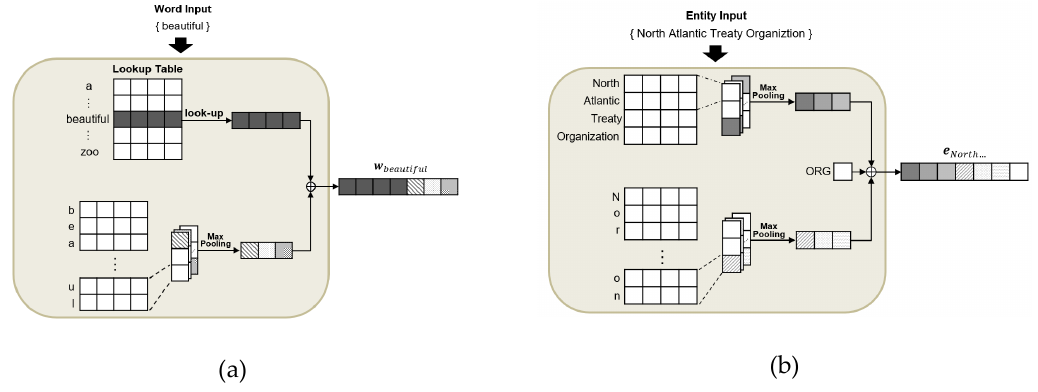
Figure 3. ( a ) Word embedding process, ( b ) Entity embedding process.